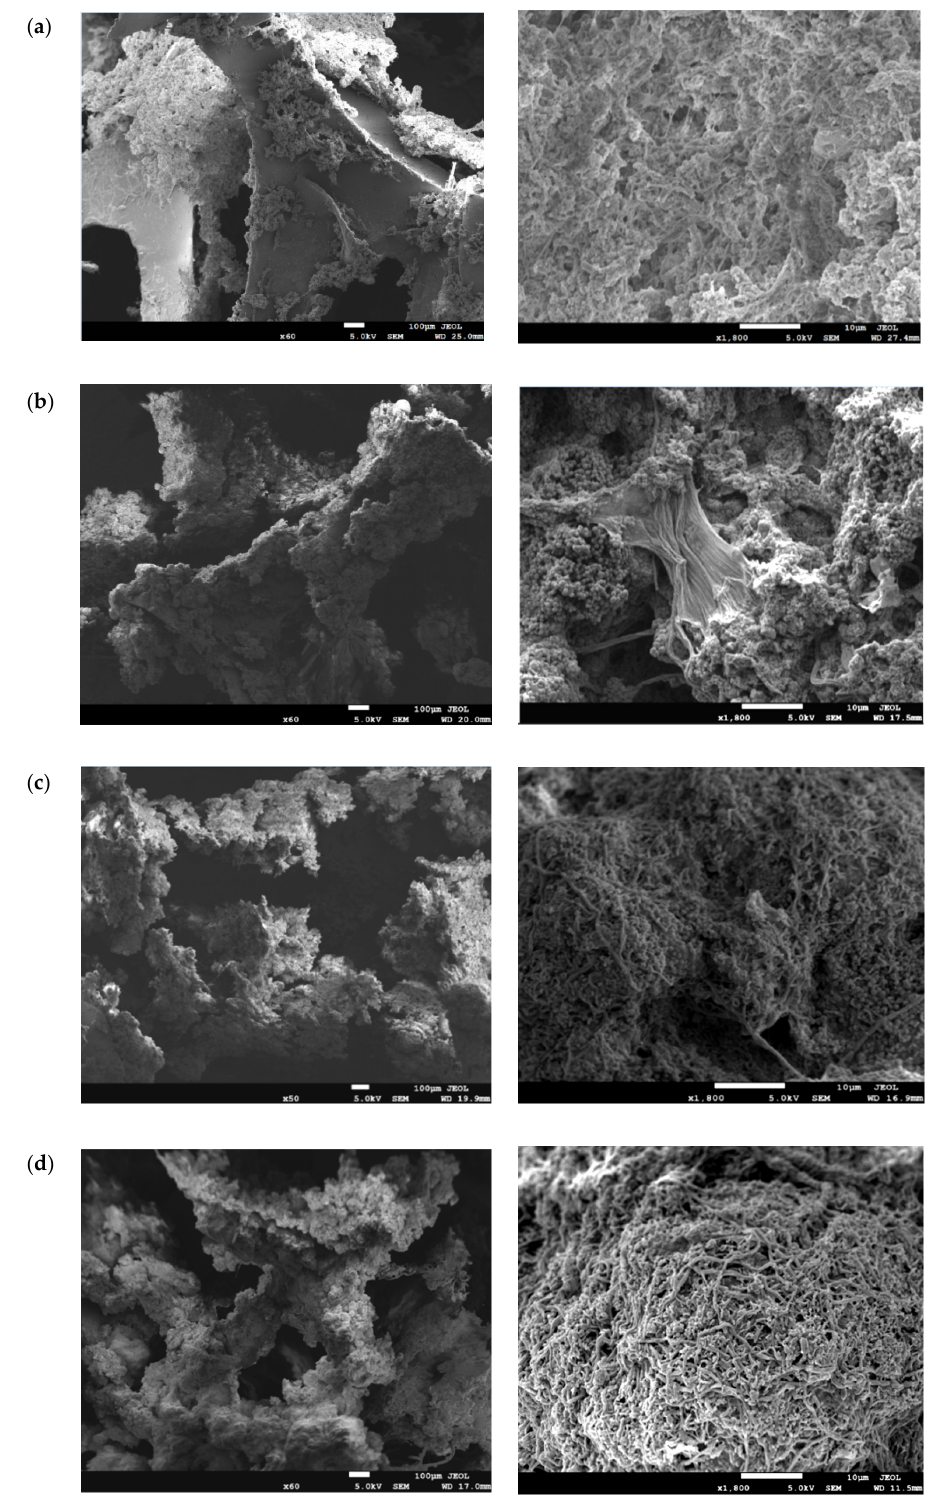
Figure 5. SEM observations of biofilms under four scenarios: ( a ) R1; ( b ) R2; ( c ) R3; ( d ) R4. (Scale bars: 100 μ m and 10 μ m).